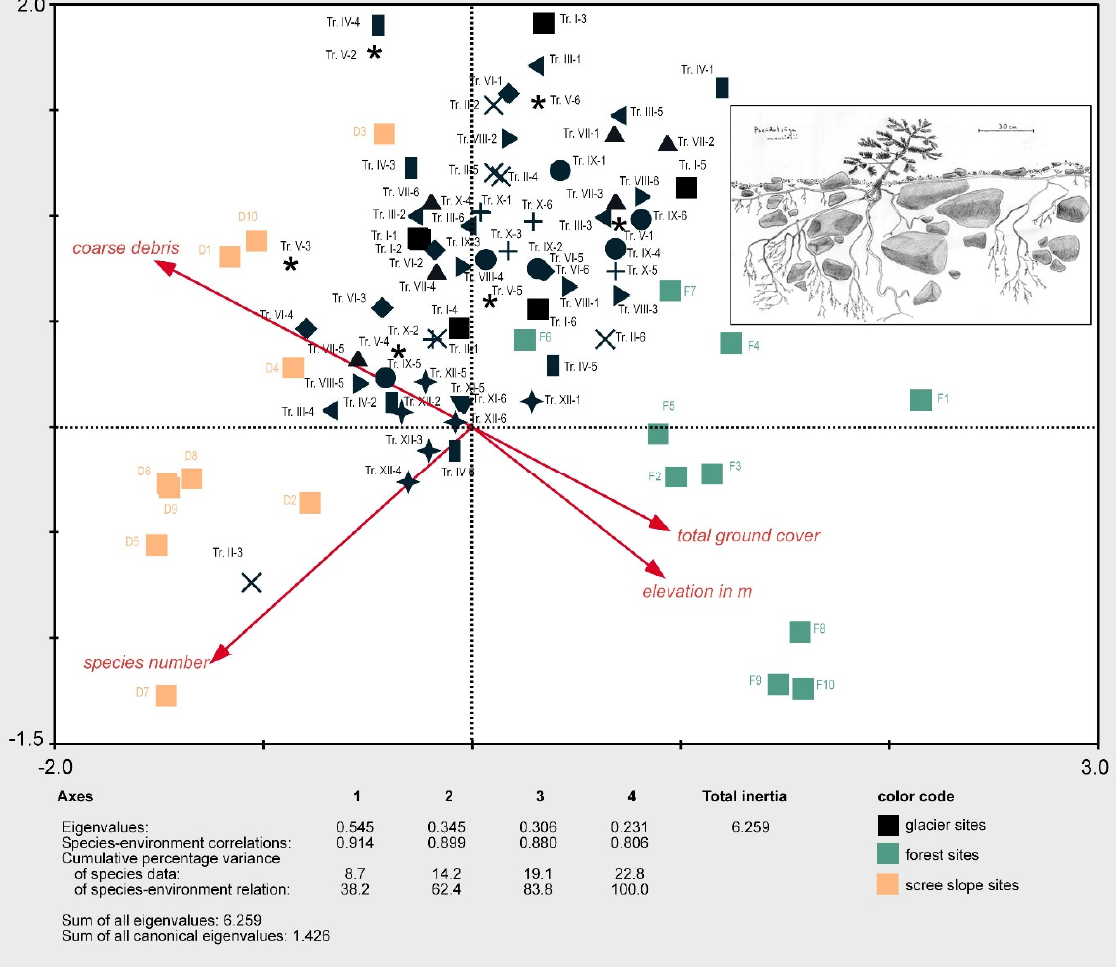
Figure 9. A canonical correspondence analysis (CCA) ordination biplot showing the floristic simi- larity of samples on the debris-covered surface of Carbon Glacier on Mount Rainier (Washington, DC, USA) in relation to samples from forest and scree slope sites in the immediate surroundings. The inset shows the disproportionally long roots of a small Pseudotsuga menziesii var. menziesii treelet growing on the supraglacial debris of Carbon Glacier (drawing by M.